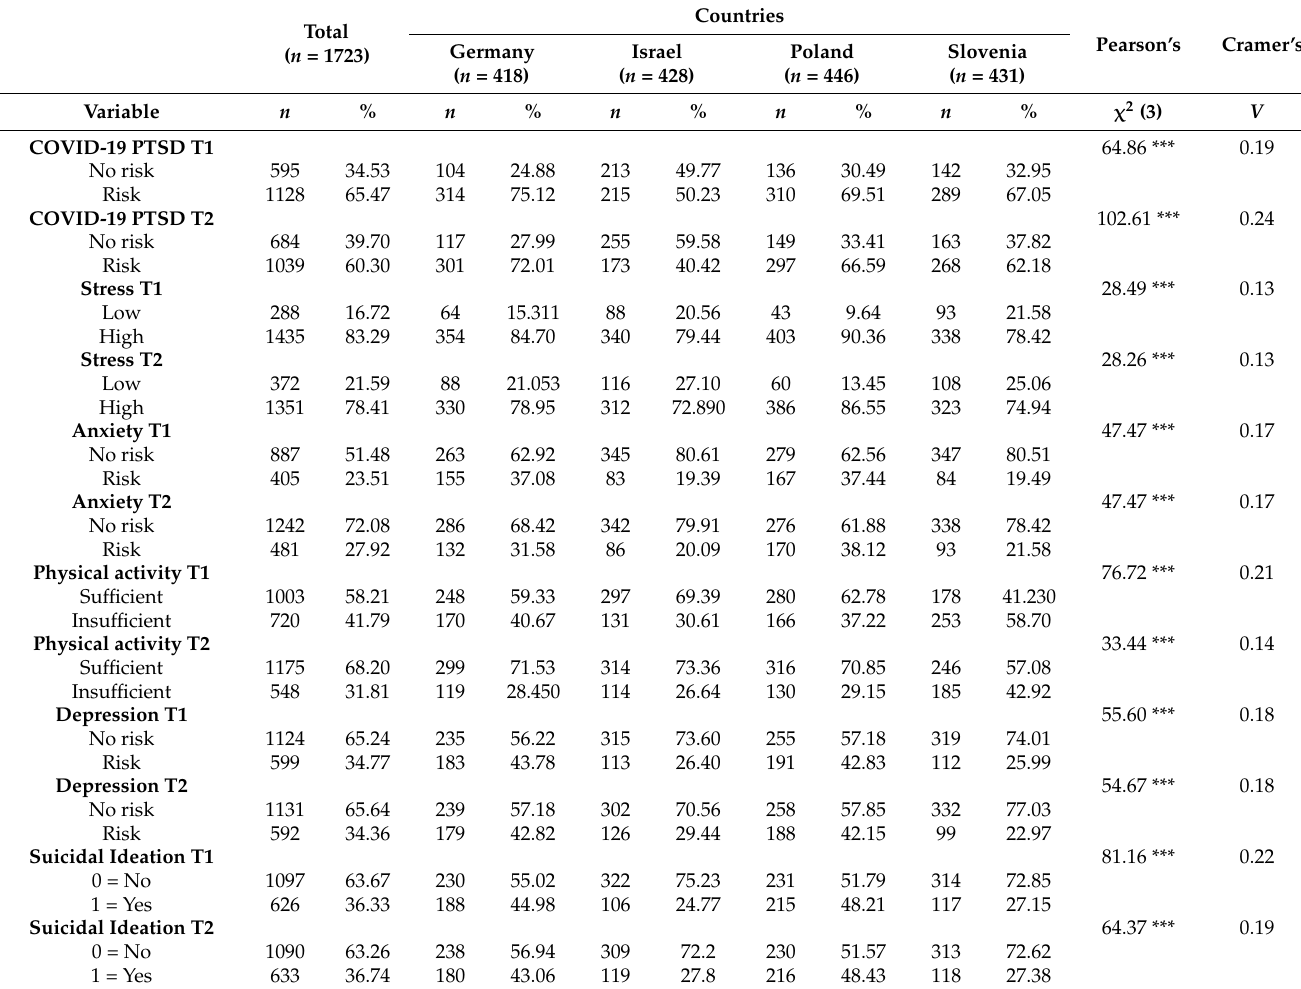
Table 2. Prevalence of mental health indices among young adults from Germany, Israel, Poland, and Slovenia in a three-month period. Total ( n = 1723)